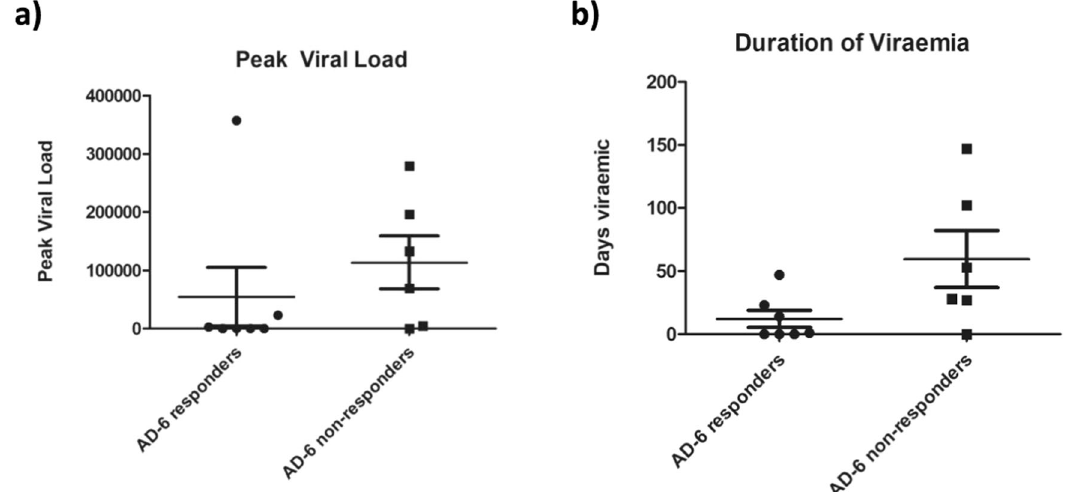
Fig. 3 | Seronegative vaccine recipients receiving an organ from a seropositive donor have reduced viral loads and duration of viraemia post-transplant. a Peak viral load post-transplant in D+R- AD-6 responders ( n =6) and non-